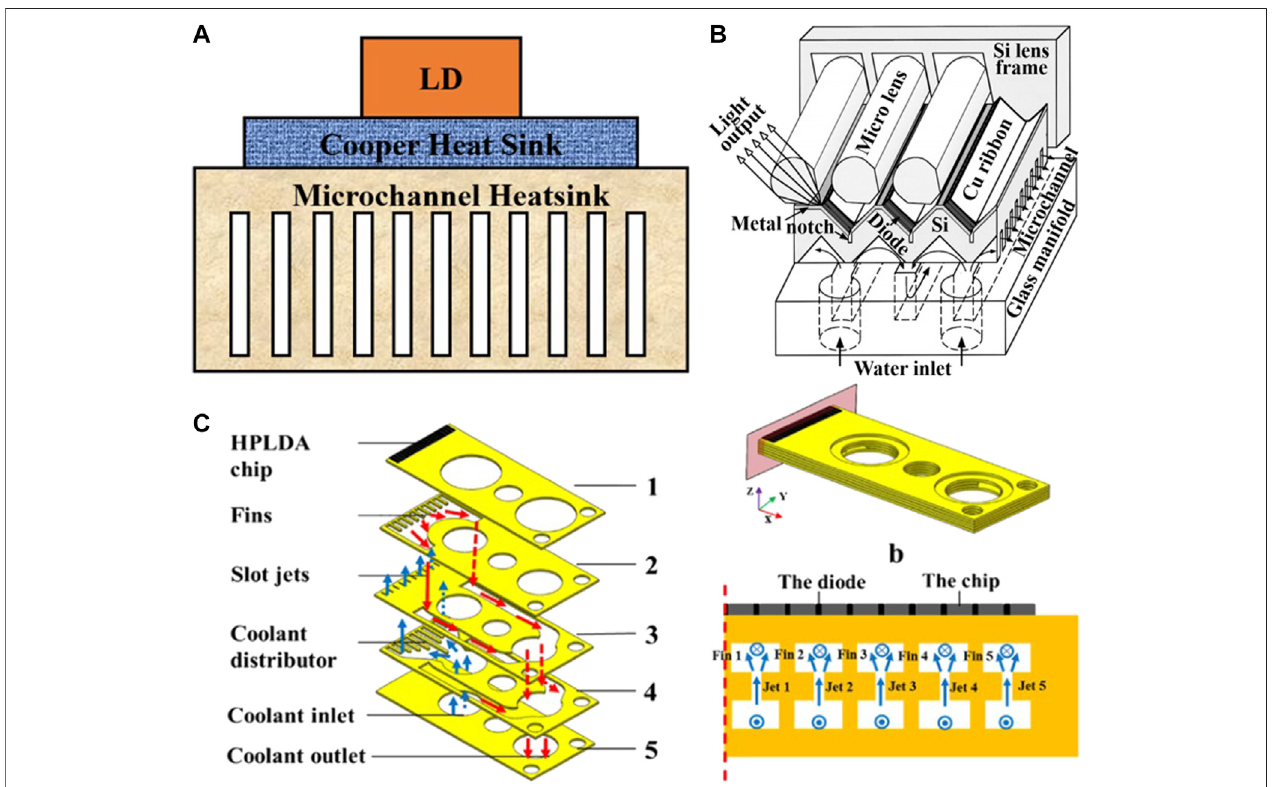
FIGURE 9 | (A) Schematic diagram of typical microchannel heat dissipation device. Adapted from [6]; (B) The structural model of using gaps as heat exchange micro-channels. Adapted from [43]. (C) The detailed structure diagram of the microchannel water-cooled heat dissipation device composed of fi ve layers of sheets. Adapted from